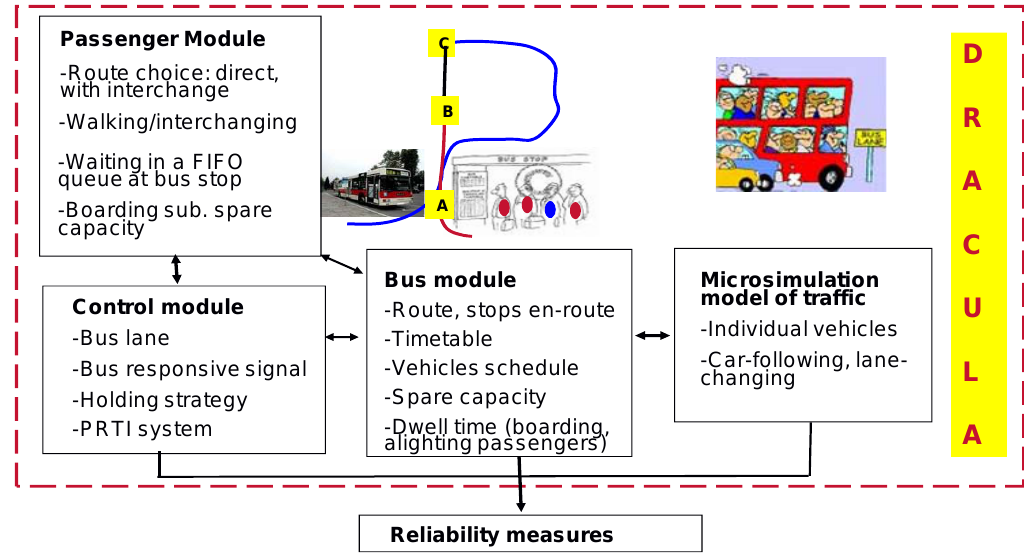
Figure 4. A modelling framework to represent public transport